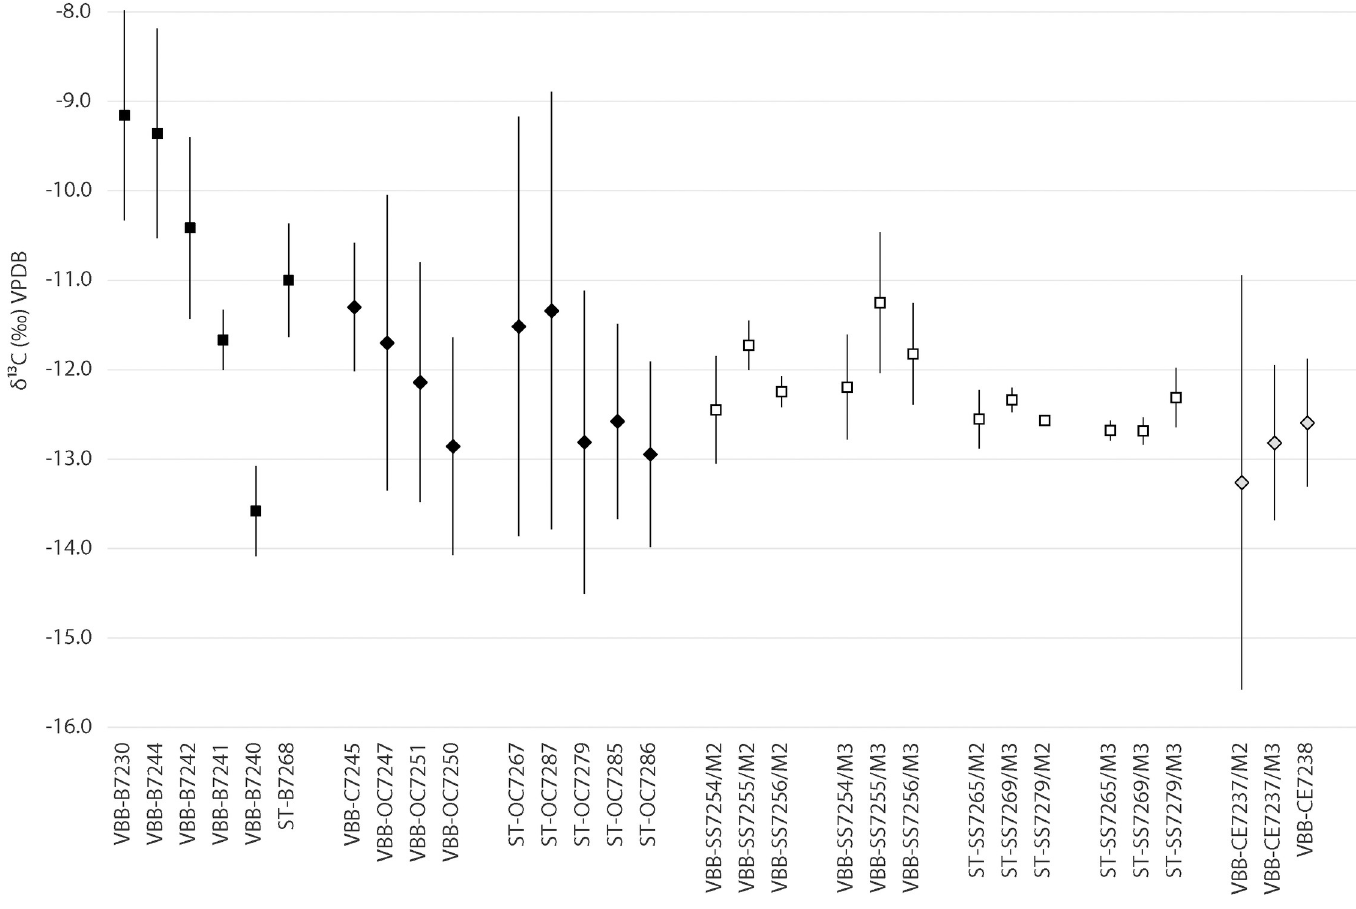
Fig 2. Comparison of δ 13 C ave , δ 13 C max and δ 13 C min from incremental samples. Cattle (B), domestic pigs (SS), sheep/goat (OC) and red deer (CE) teeth from Vin č a-Belo brdo (VBB) and Stubline (ST).